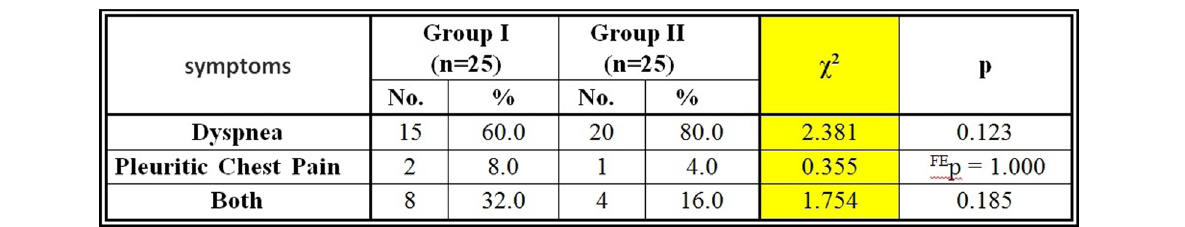
Table 2 Comparison between the studied groups as regard the main presenting